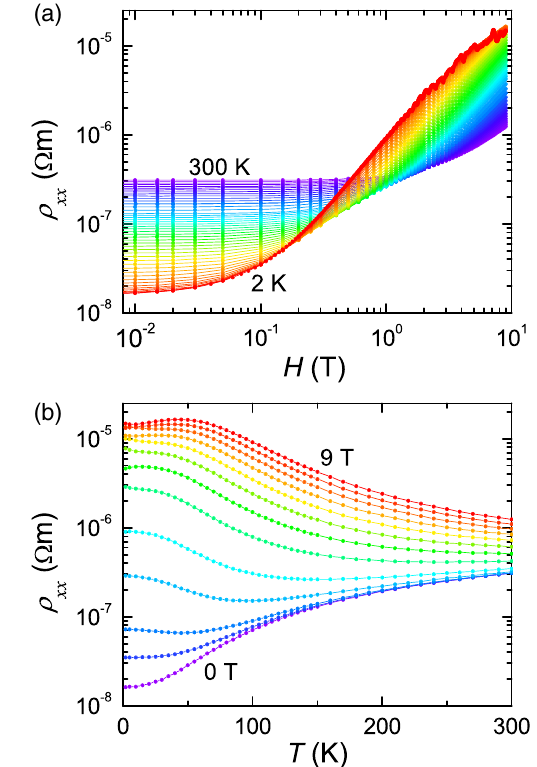
FIG. 1. Magnetoresistance of TaP. (a) Magnetic field depend- ð H Þ measured at temperatures of T ¼ 2 K and from 5 to ence ρ xx 150 K in intervals of 5 K and from 160 to 300 K in intervals of 10 K (from red to purple). (b) Temperature dependence ρ ð H Þ in (a) at magnetic fields of H ¼ 0 , 0.1, constructed from ρ xx 0.2, and 0.5 Tand from 1 to 9 T in intervals of 1 T (from purple to red). The data are taken from sample